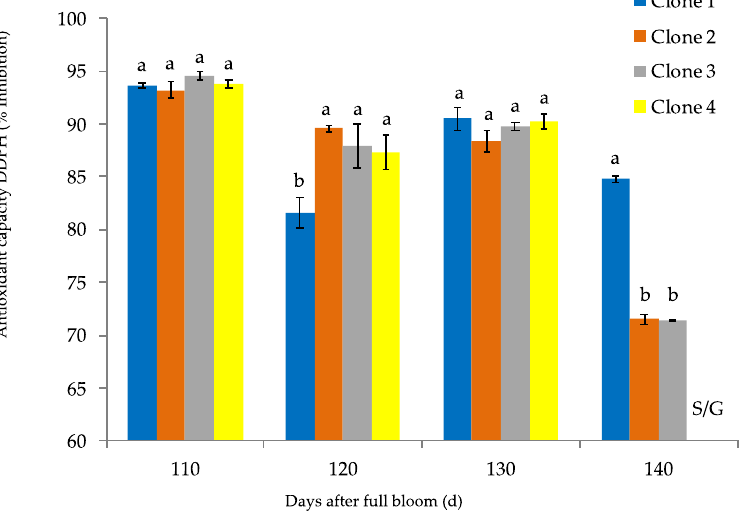
Figure 6. Antioxidant capacity (% inhibition) of the fruit for four calafate clones according to the different harvest dates. Lowercase letters indicate significant differences between the different clones for the same harvest date, according to the Fischer test ( p < 0.05). S/G = no harvest.